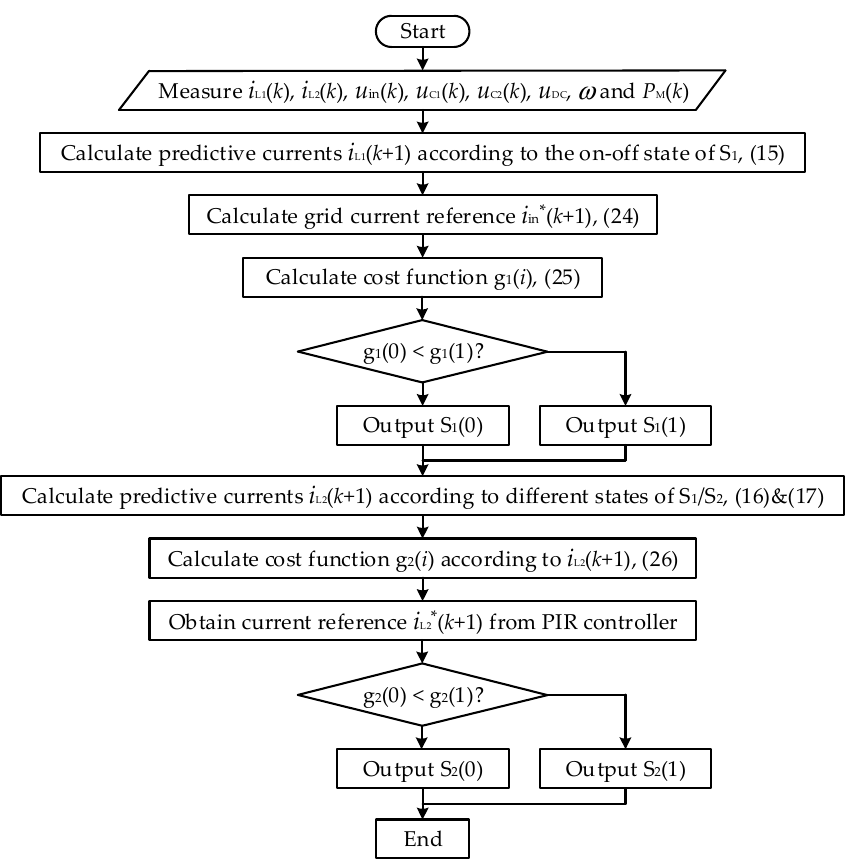
Figure 4. The proposed MPCC control strategy.